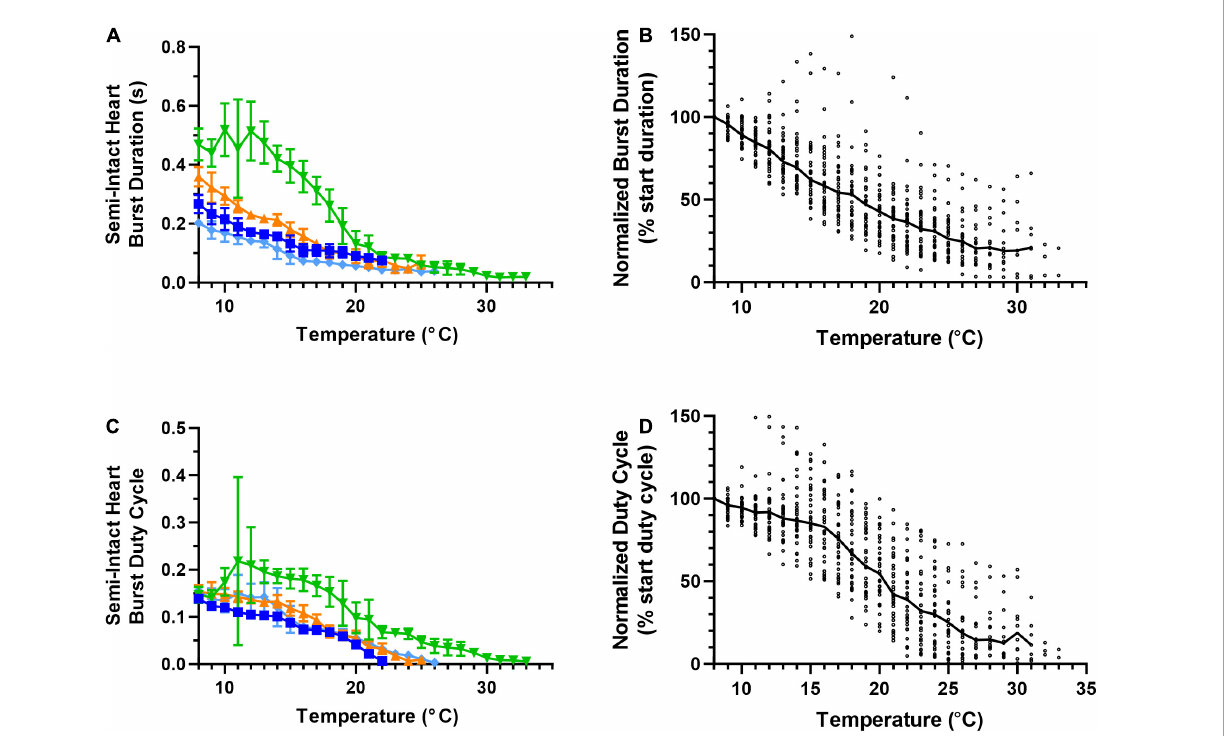
FIGURE4 Responses of semi-intact cardiac neuromuscular system to an increasing temperature ramp: cardiac ganglion burst duration and duty cycle. Values show data averaged in 1 ◦ C bins, with the data plotted at the center of each bin. (A) A plot of cardiac ganglion burst duration within semi-intact hearts as a function of temperature for the same four semi-intact preparations in Figures 3A, C . CG burst duration decreases rapidly with temperature, and eventually stabilizes at a floor duration. (B) A plot of CG burst duration normalized to the duration at 8 ◦ C for all semi-intact preparations, showing the decrease in contraction duration across all temperatures ( N = 35 until the first preparation crashes at 19 ◦ C; N decreases from that temperature on). (C) Plot of CG burst duty cycle as a function of temperature for the same four preparations plotted in panel (A) . CG burst duty cycle decreases across the entire range of temperatures tested. (D) A plot of CG burst duty cycle as a function of temperature, with the duty cycle for each preparation at each temperature step normalized to the burst duty cycle at 8 ◦ C ( N = 35 until the first preparation crashes at 19 ◦ C; N decreases from that temperature on). Duty cycle decreases with increasing temperature over the entire range of temperatures. All data points in panels (A,C) show mean ± SD for a given parameter at each temperature step. In panels (B,D) , the solid back line connects median normalized burst duration and duty cycle, respectively at each temperature step. Medians are omitted when N ≤